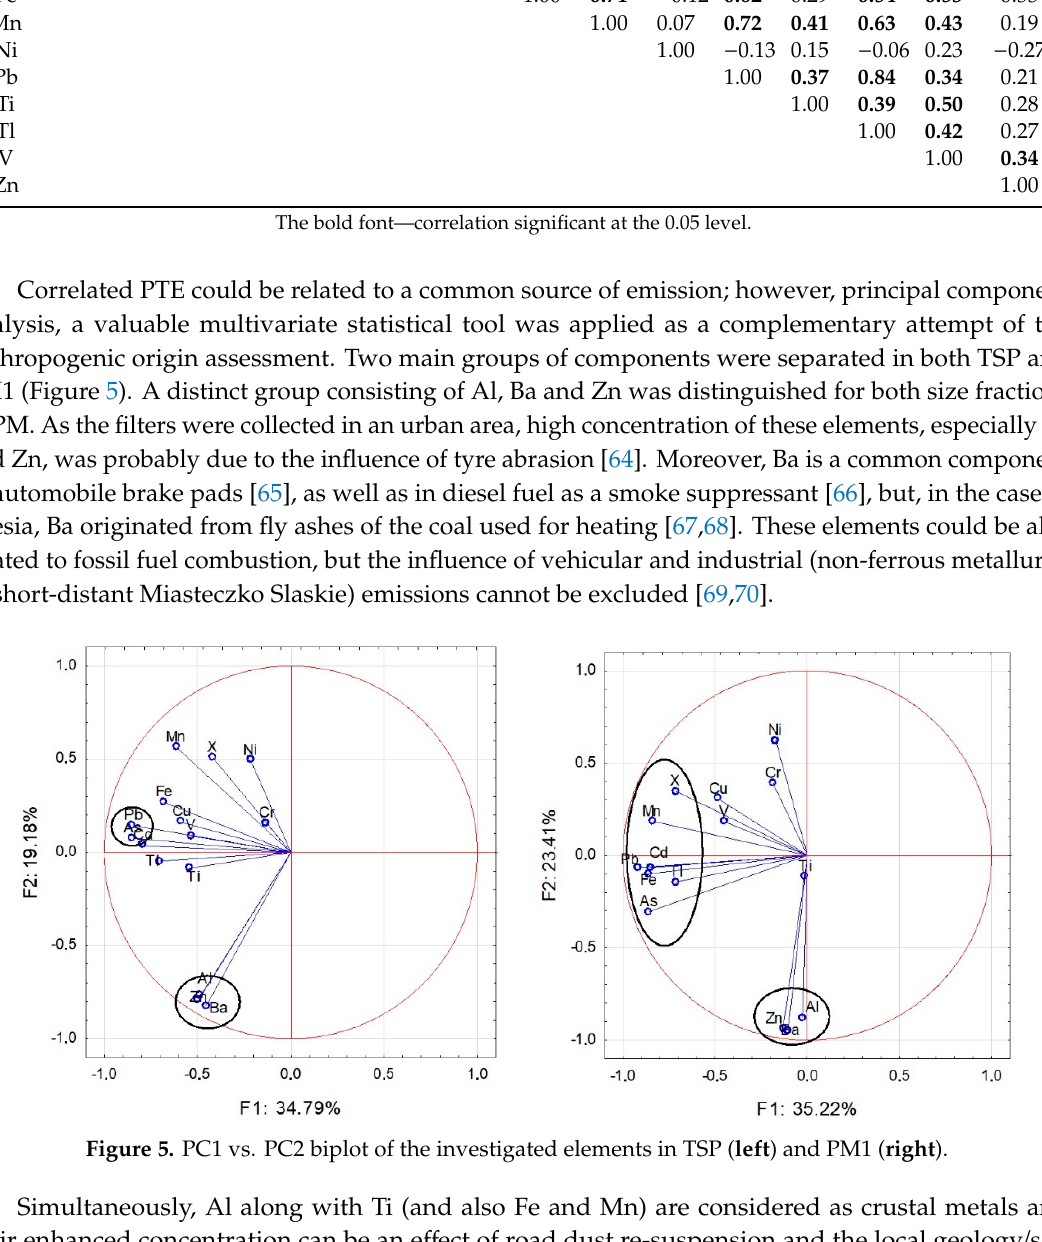
The bold font—correlation significant at the 0.05 level.